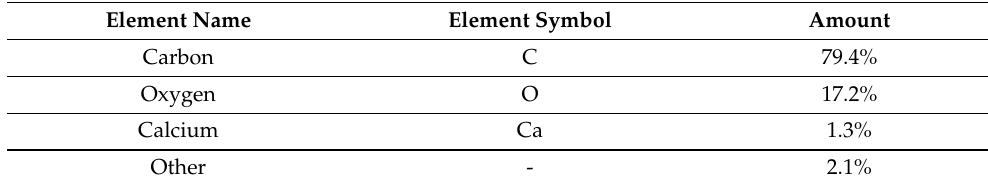
Table 3. Chemical composition of material M3.